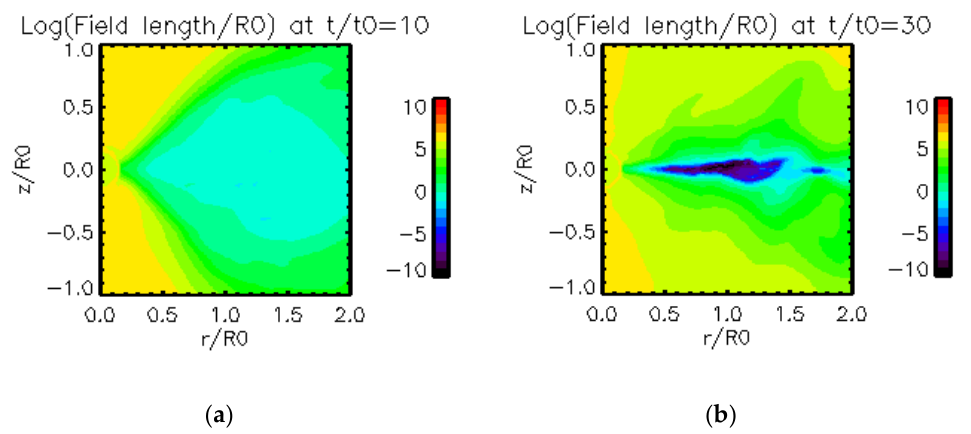
Figure 6. Distributions of the Field length λ F / R 0 of Model 2. ( a ) Result at t / t 0 = 10 ( b ) Result at t / t 0 = 30 .